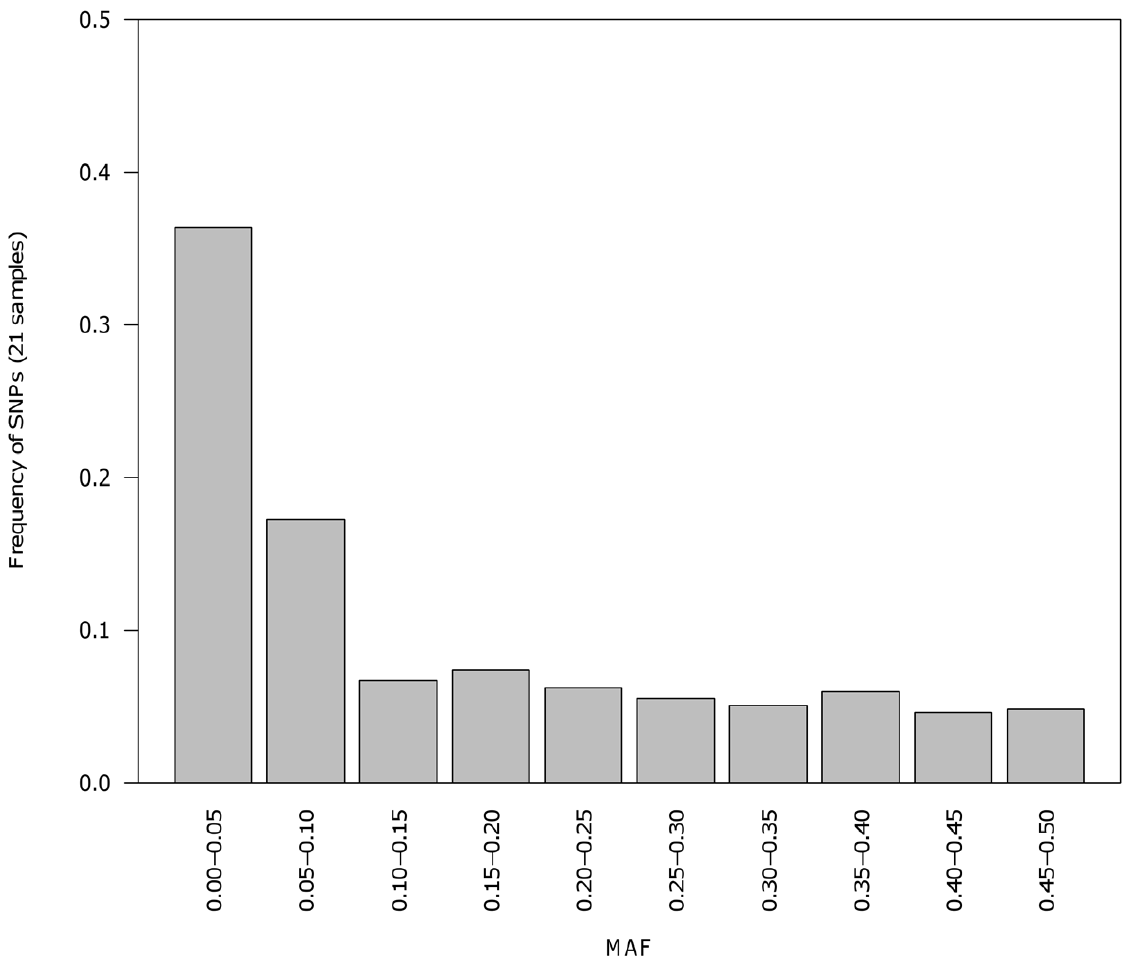
Figure 4. Minor allele frequency (MAF) distribution. The distribution of the MAF in 578 SNPs typed in 18 populations across the eastern herring distribution.